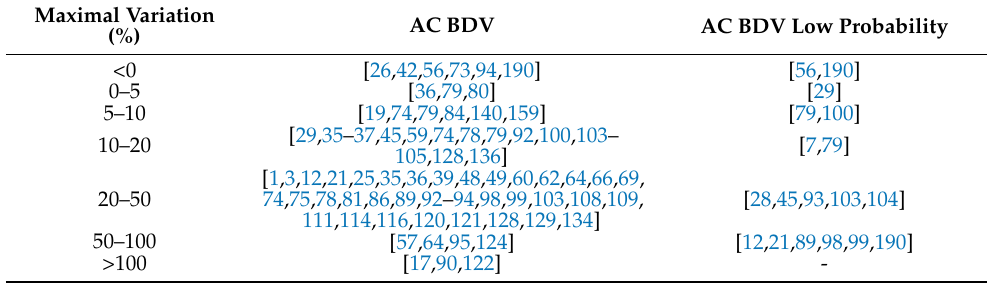
Table 15. Maximal variations of AC breakdown voltage of nanofluids with respect to the base